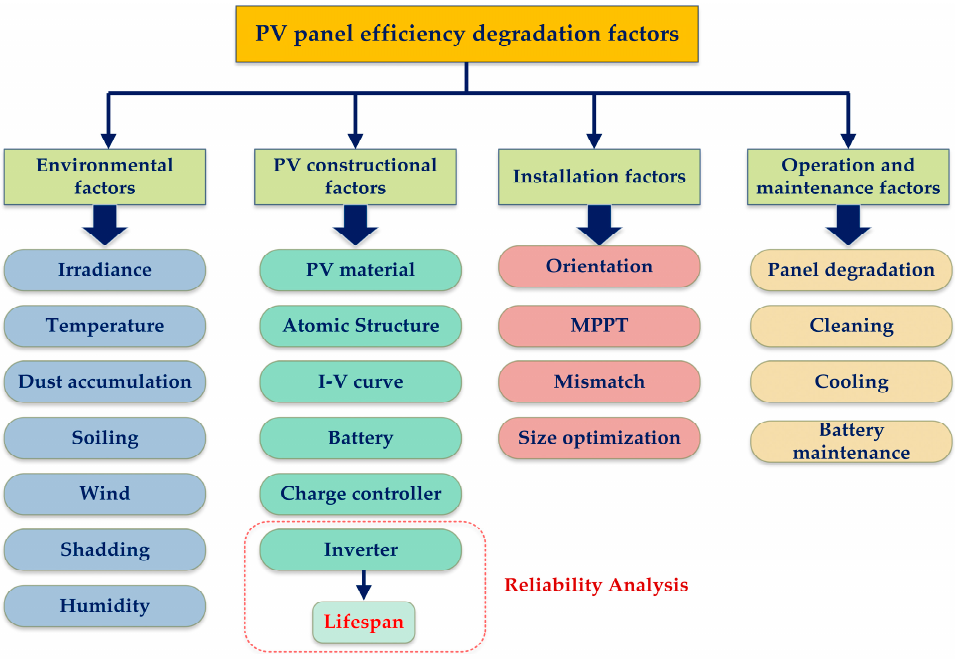
Figure 2. PV panel e ffi ciency degradation factors.